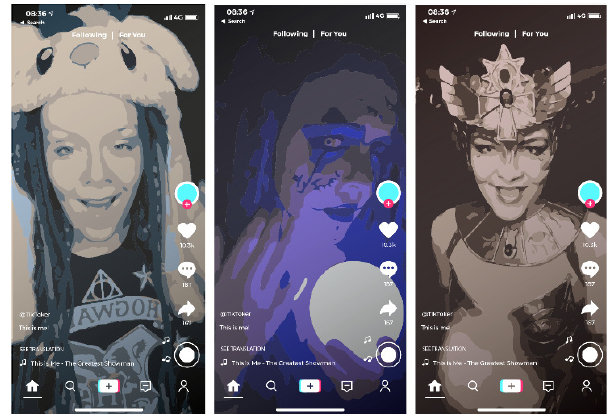
Figure 11. Illustrated TikTok post about culture and other (cosplay).